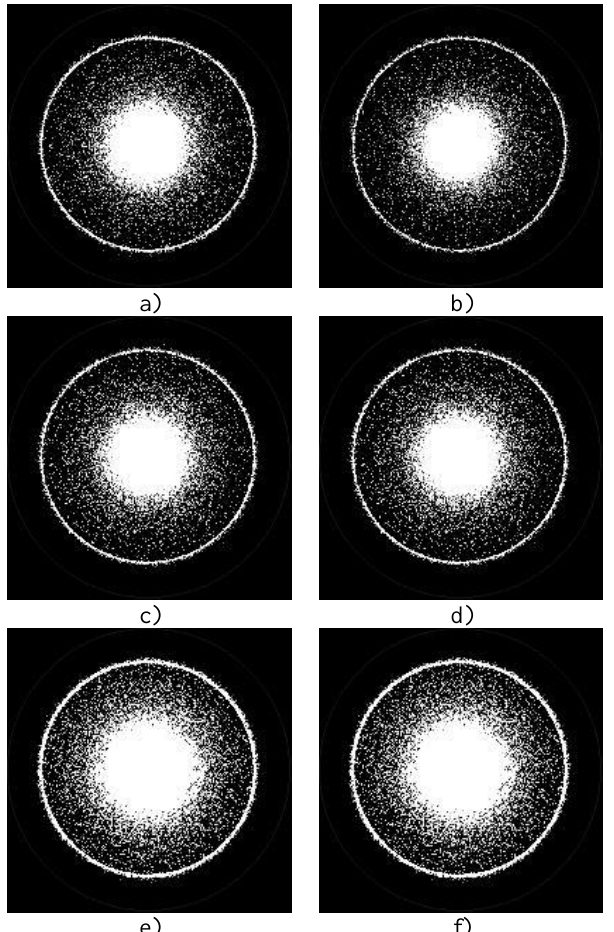
Fig. 6. The distribution of the scattered light in the second focal plane of the ellipsoidal reflector in the reflected light for multi-layered model of human shoulder tissue (a, c, and e) and finger (b, d, and f) for the incident laser beam diameter 0.01 mm (a, b), 0.5 mm (c, d), and 1.25 mm (e, f).